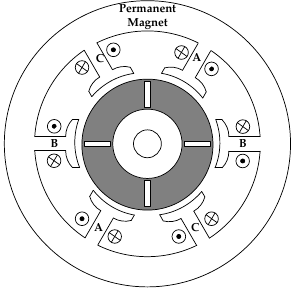
Figure 17. Structure of brushless DC motor [117].